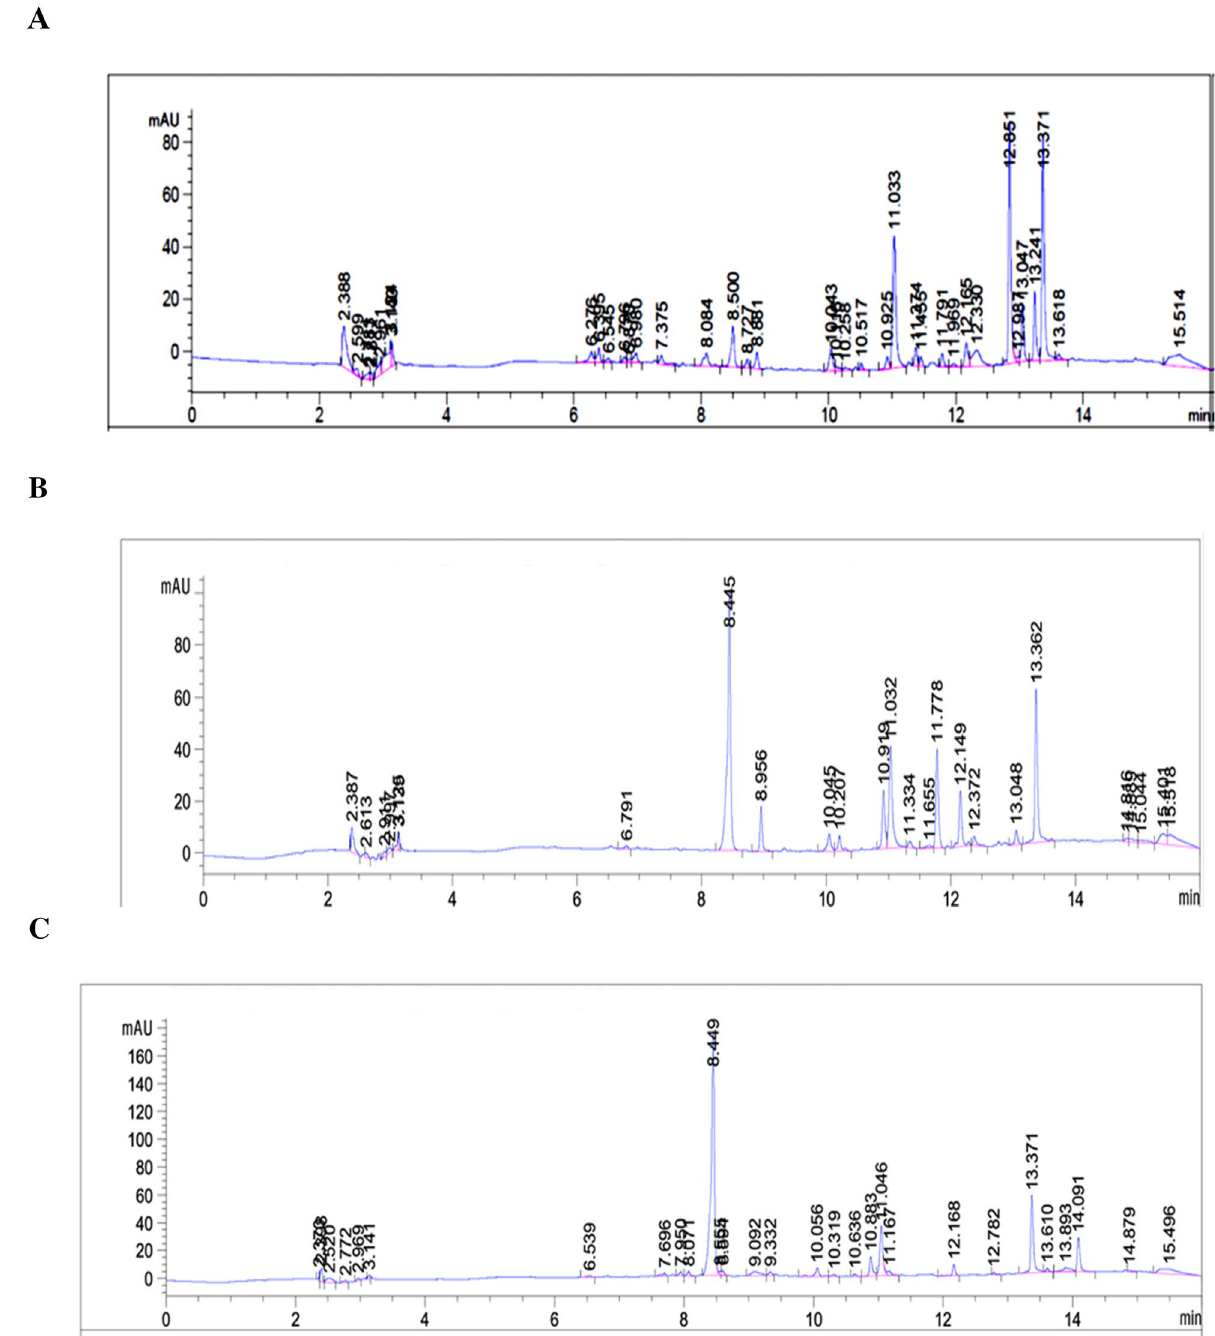
Figure 10. Chemical analysis of the fungal extracts, Chaetomium sp, ( A ), F. venenatum ( B ) and Bipolaris sp. ( C ) by Analytical HPLC–DAD Chromatograms at 275